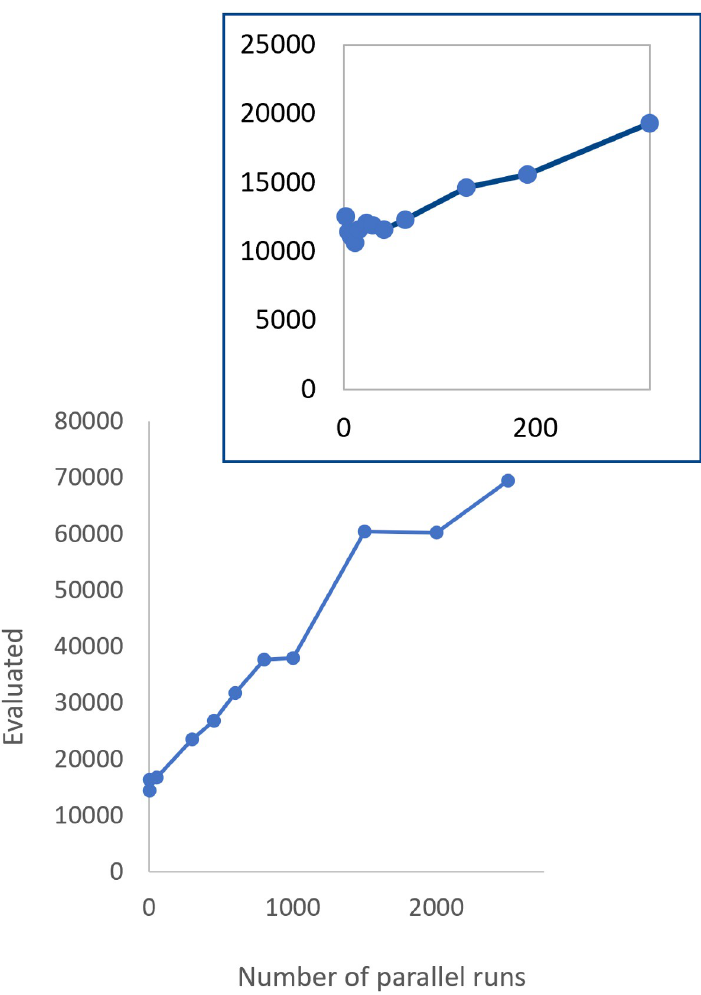
Fig 9. In silico tests with parallel RMHC: Effectiveness vs number of parallel processes. (4 domains, 6+4 defined positions out of 26, W = 220; mean mutation rate is 20 per chromosome). The mean number of fitness evaluations are computed over 100 runs per test. Standard deviations are of value comparable to the